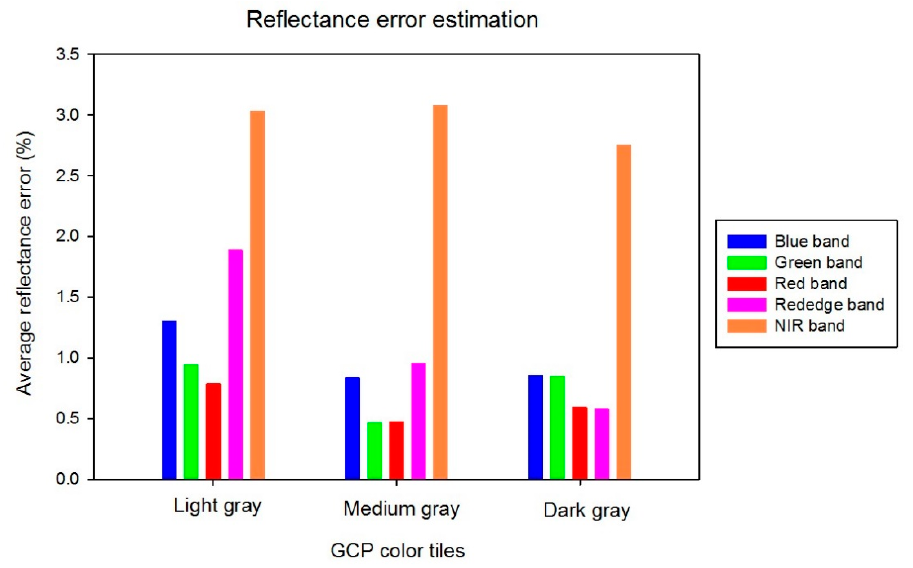
Figure 11. Average reflectance calibration error for each color tile and each band.